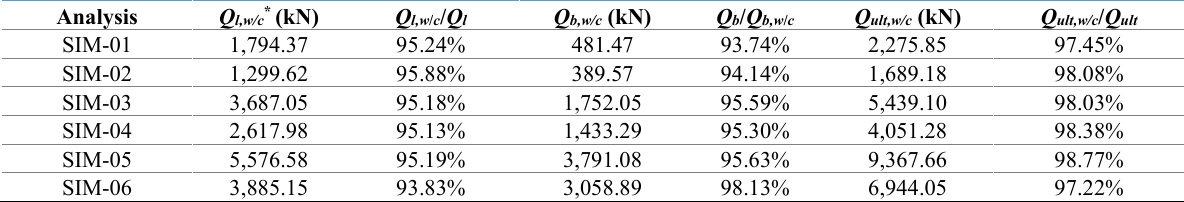
Table 3. Results for the analyses at w/D =